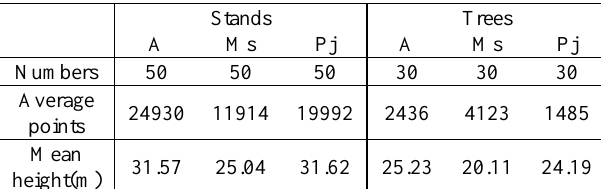
Table 1. The statistical information of the forest stands and individual trees used in this study. A: aspen; Ms: sugar maple; Pj: jack pine. Height is calculated as the elevation difference between the highest point and the lowest point.